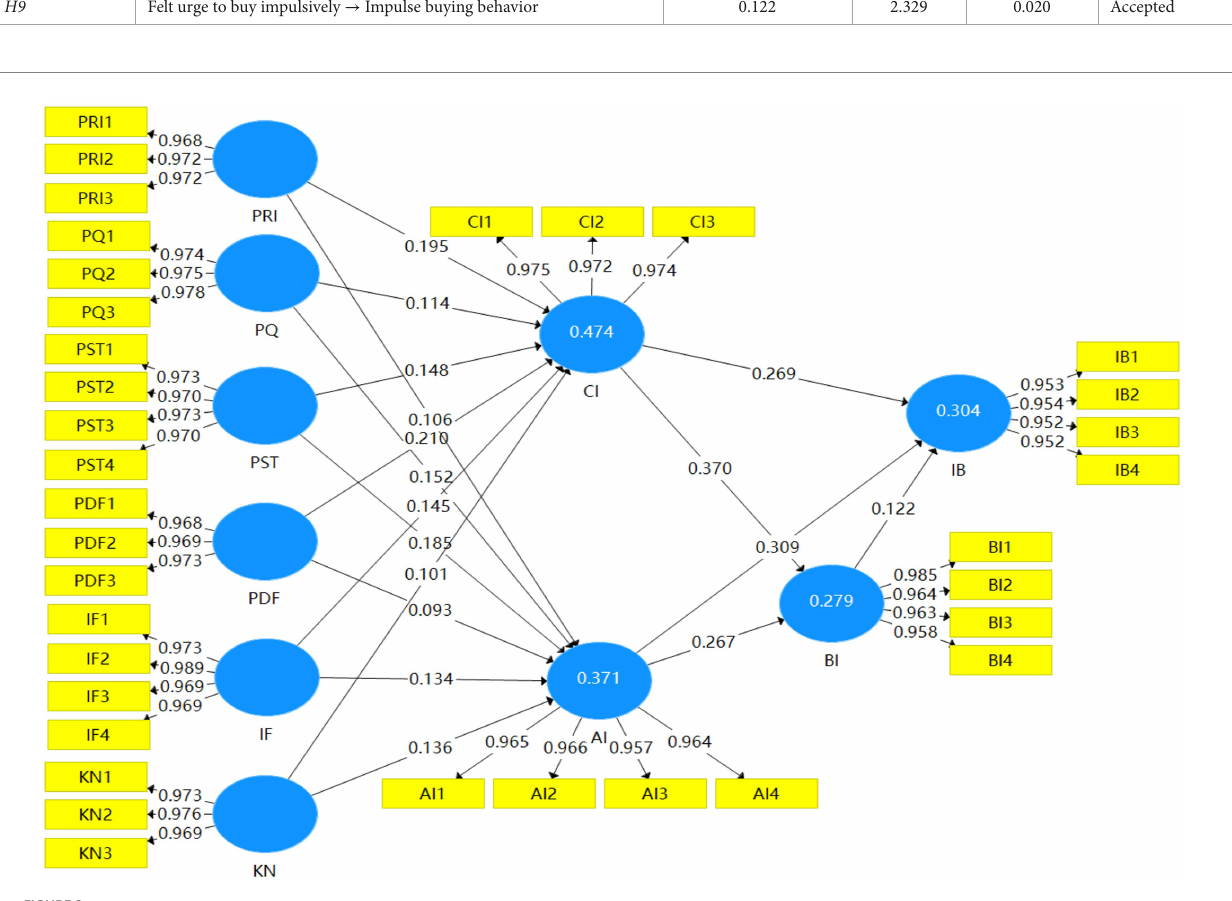
FIGURE 2 Structural model